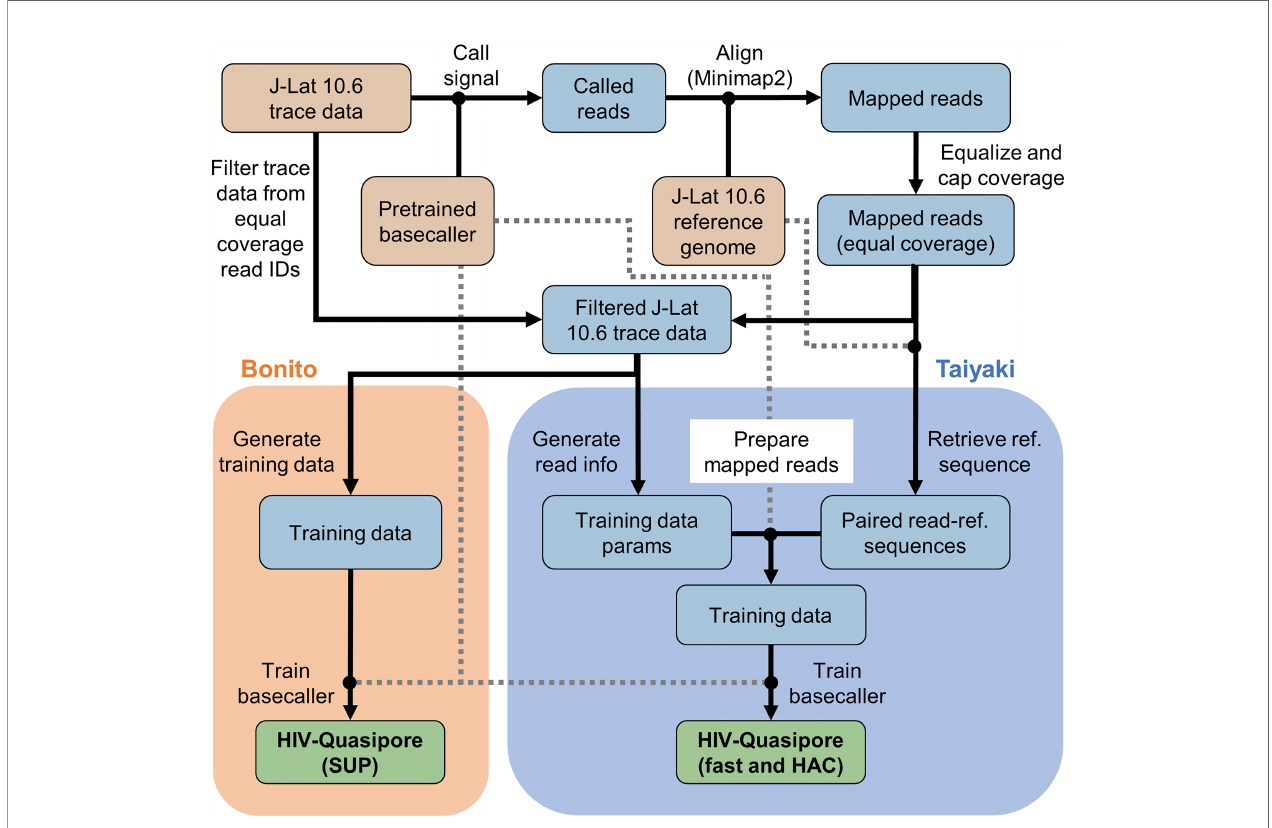
FIGURE 1 | HIV-Quasipore training overview. The HIV-Quasipore training pipeline was designed to re fi ne a pretrained fl ip- fl op or Bonito basecaller using J-Lat 10.6 nanopore trace data and a J-Lat 10.6 reference genome. Brown cells indicate a pipeline input, blue cells indicate a pipeline intermediate, and green cells indicate the fi nal HIV-Quasipore basecallers. Gray-dash lines are intended to ease visualization of the otherwise overlapping black lines. Orange shading represents steps exclusive to Bonito model training. Blue shading represents steps exclusive to fl ip- fl op model training using the Taiyaki